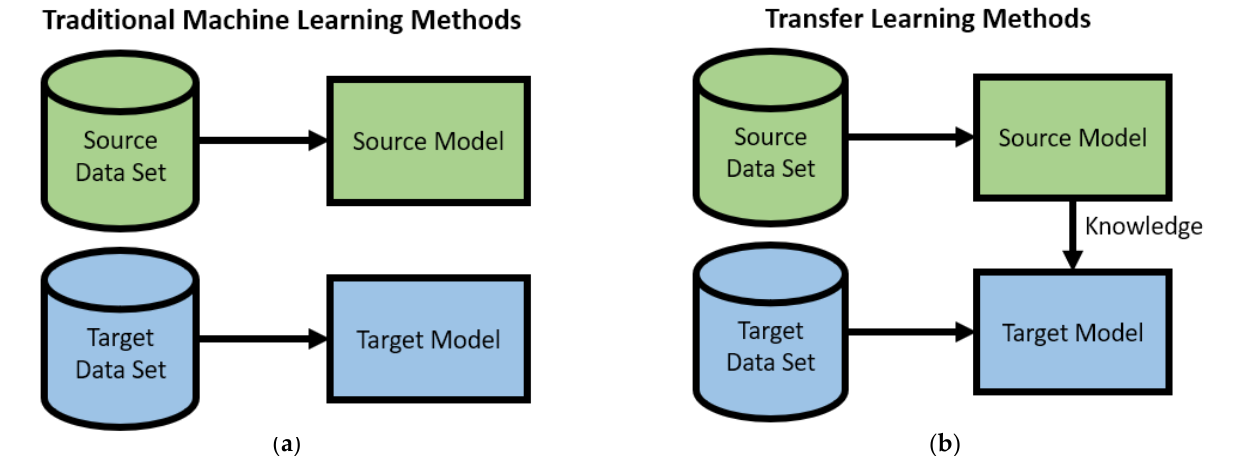
Figure 2. Difference between traditional and transfer ML methods: ( a ) source and target datasets are used to train separate models that do not interact; ( b ) source dataset is used to train a model and the derived knowledge is used to influence the target model for the target dataset.